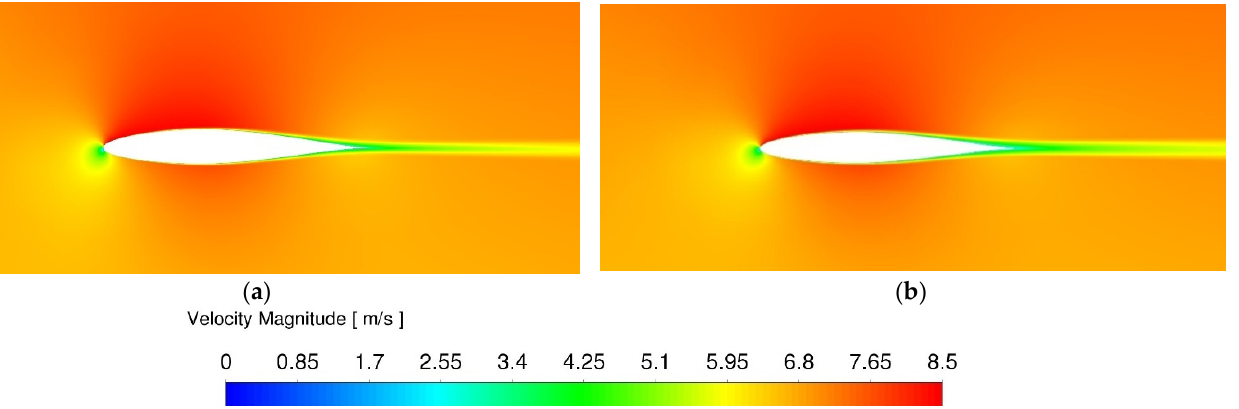
Figure 14. Velocity magnitude around airfoil at 50% of the original wingspan, with AoA = 16°: ( a ) in one-phase flow; ( b ) in two-phase flow.